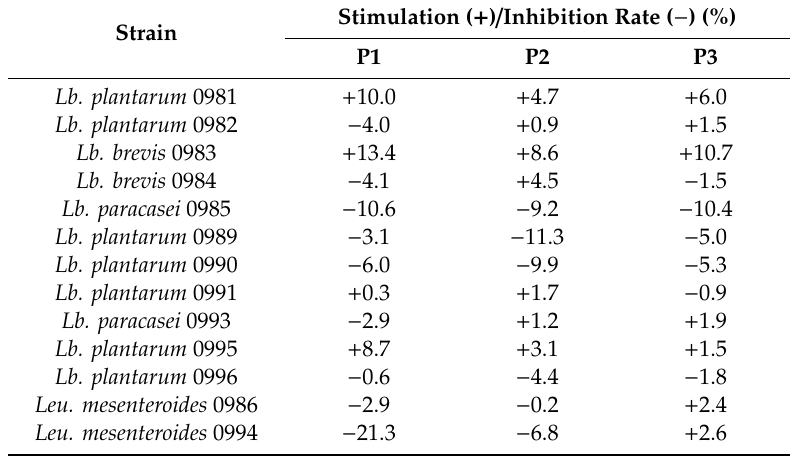
Table 3. Stimulation (+) or inhibition ( − ) rates (%) for adhesion of lactic acid bacteria to Caco-2 cells in the presence of apple pomace preparations: P1, P2, and P3.